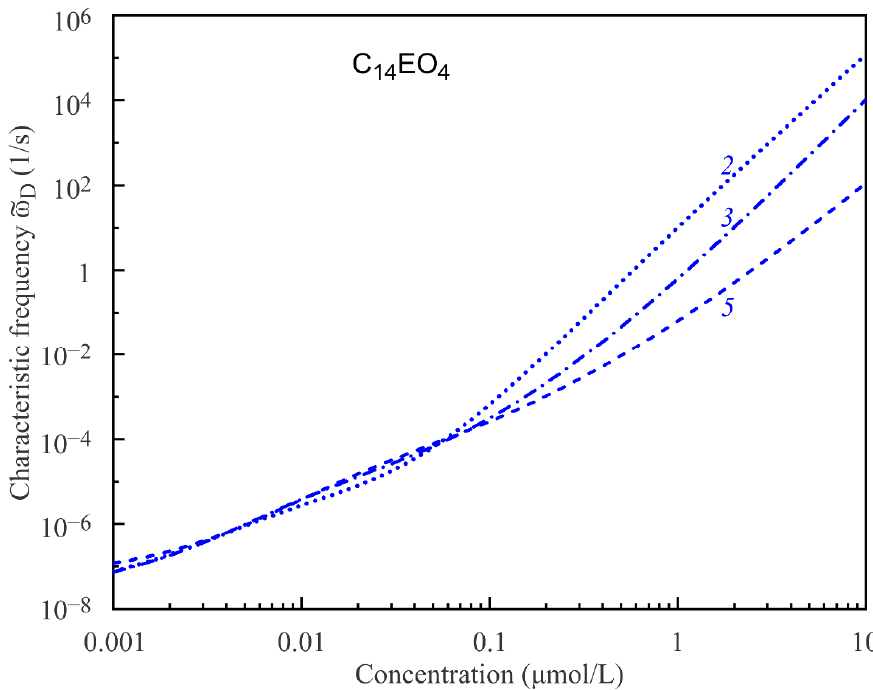
Figure 6. Characteristic frequency D (c) for C 14 EO 4 solutions calculated assuming various numbers of states s (dotted line for s = 2, dash-dotted line for s = 3, and dashed line for s = 5) with the parameter sets presented in Table 1 and the diffusion coefficient D = 5 ∙ 10 − 9 m 2 /s. For details see text.